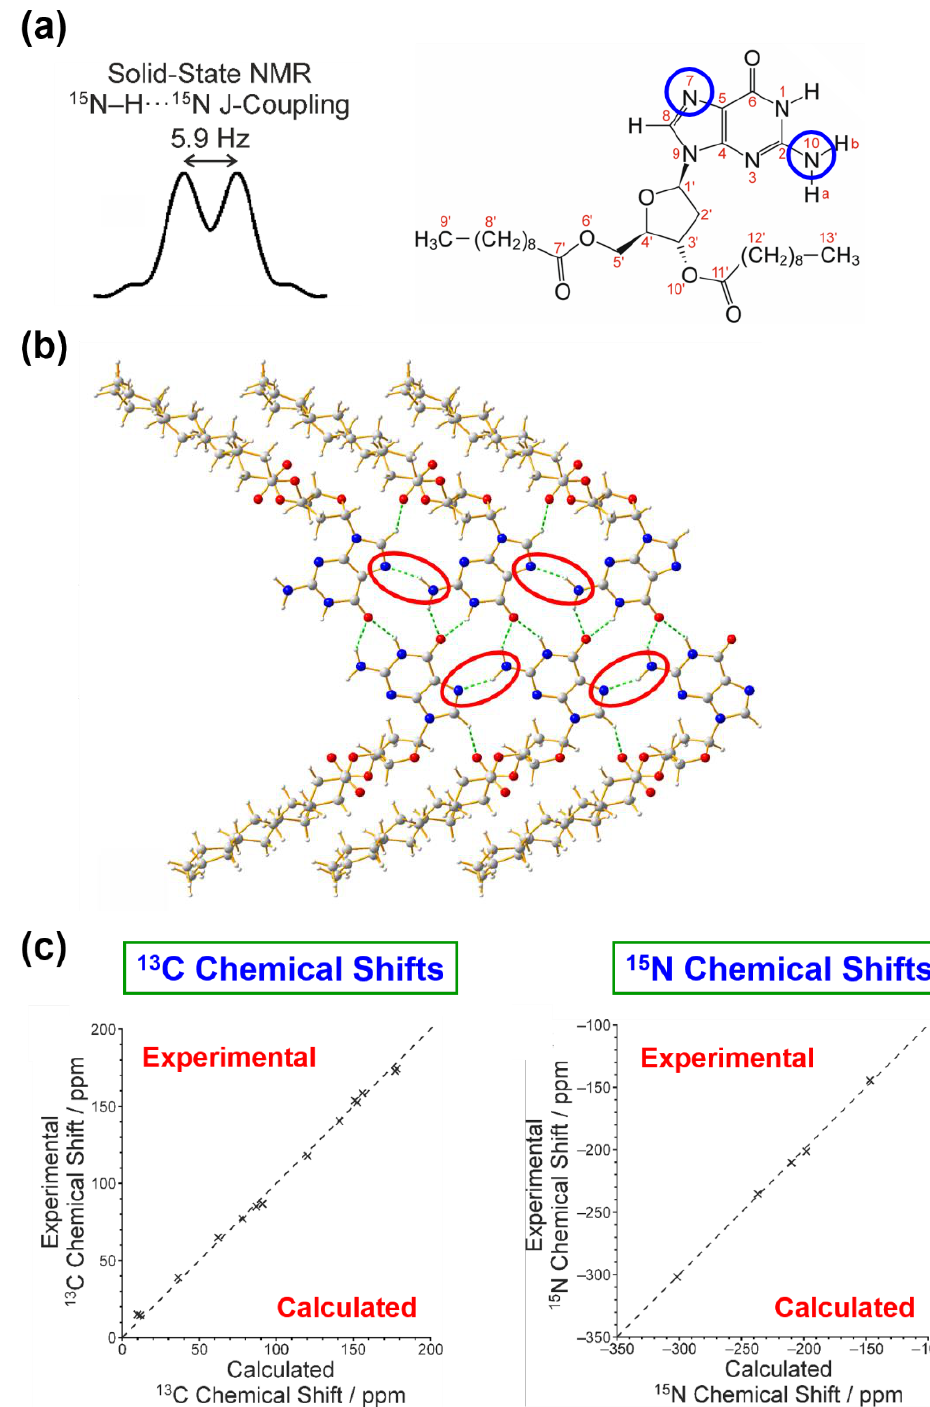
Figure 7. ( a ) Evidence from solid-state 15 N NMR data recorded for polymorph I of dG(C 10 ) 2 for a 2h J N7N10 coupling of 5.9 Hz, which suggests that the crystal structure contains a relatively strong N – H ⋯ N hydrogen bond involving N7 and N10 (N7 and N10 are highlighted by blue circles). ( b ) The final refined crystal structure of polymorph I of dG(C 10 ) 2 with the N10 – H ⋯ N7 hydrogen bonds highlighted by red ellipses. ( c ) Comparison of experimental and DFT-GIPAW calculated values of isotropic 13 C NMR and 15 N NMR chemical shifts for polymorph I of dG(C 10 ) 2 . This work exploited the fact that measurements of internuclear coupling from solid- state NMR data yield information on specific intermolecular interactions, focusing on measurement of indirect (electron-coupled) dipole – dipole interactions (i.e., J-coupling)